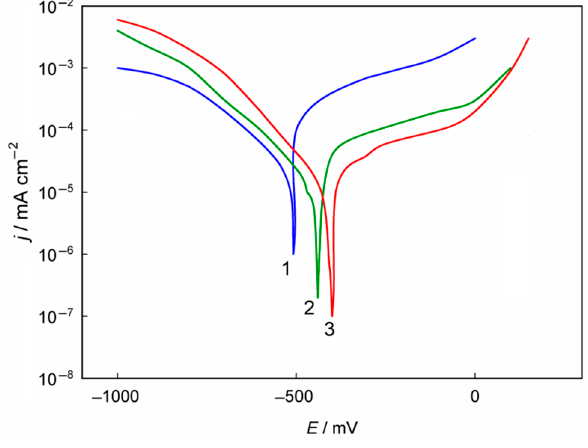
Figure 3. Polarization curves characterizing electrochemical behavior of Ni (1), Ni–TiO 2 (5%) (2) and Ni–TiO 2 (10%) (3) coatings in a 3% NaCl aqueous solution. Potential scan rate was 1 mV s –1 . Table 1. Corrosion parameters of nickel and nickel–titania coatings in a 3% NaCl water solution determined from the results of potentiodynamic measurements.